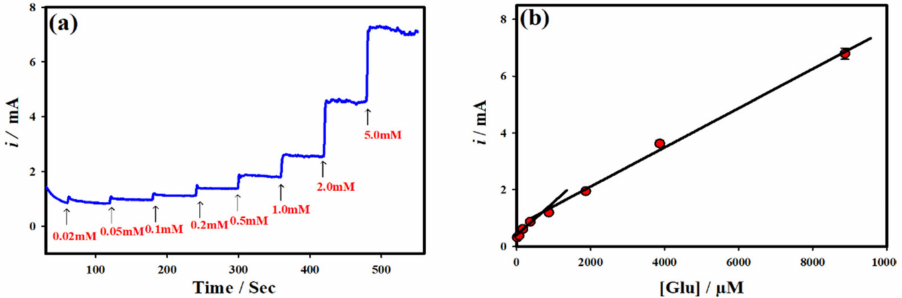
Figure 4. ( a ) CA i-t curve of NC-NiS@NS-NiS|NF sensing electrode measured in 1.0 M KOH under different concentrations of glucose (20.0 µ M–5.0 mM) with limited addition at the constant applied potential 0.50 V. ( b ) The corresponding calibration